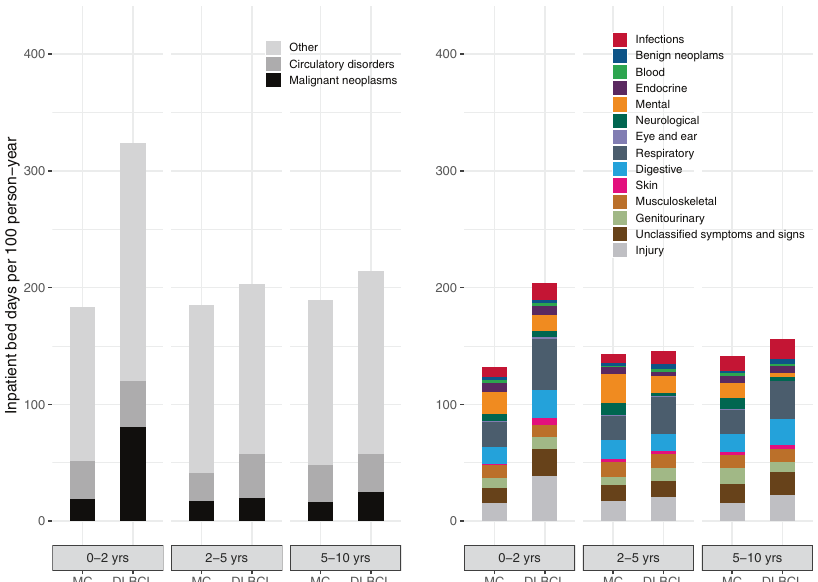
Fig. 2 Incidence rates of inpatient bed days strati fi ed by ICD-10 chapter among survivors and matched comparators in different time periods (0 – 2, 2 – 5, 5 – 10 years after the index date). The incidence rates of conditions included in the “ Other ” category in the left-hand panel are displayed in the right-hand panel. DLBCL diffuse large B-cell lymphoma, MC matched comparators.